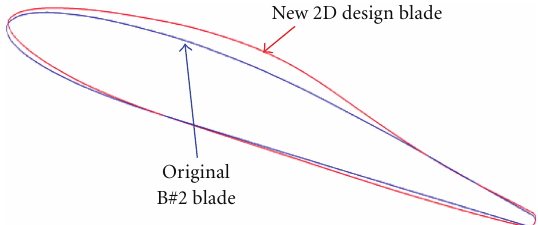
Figure 14: Blade shape obtained from 2D blade design optimiza- tion.